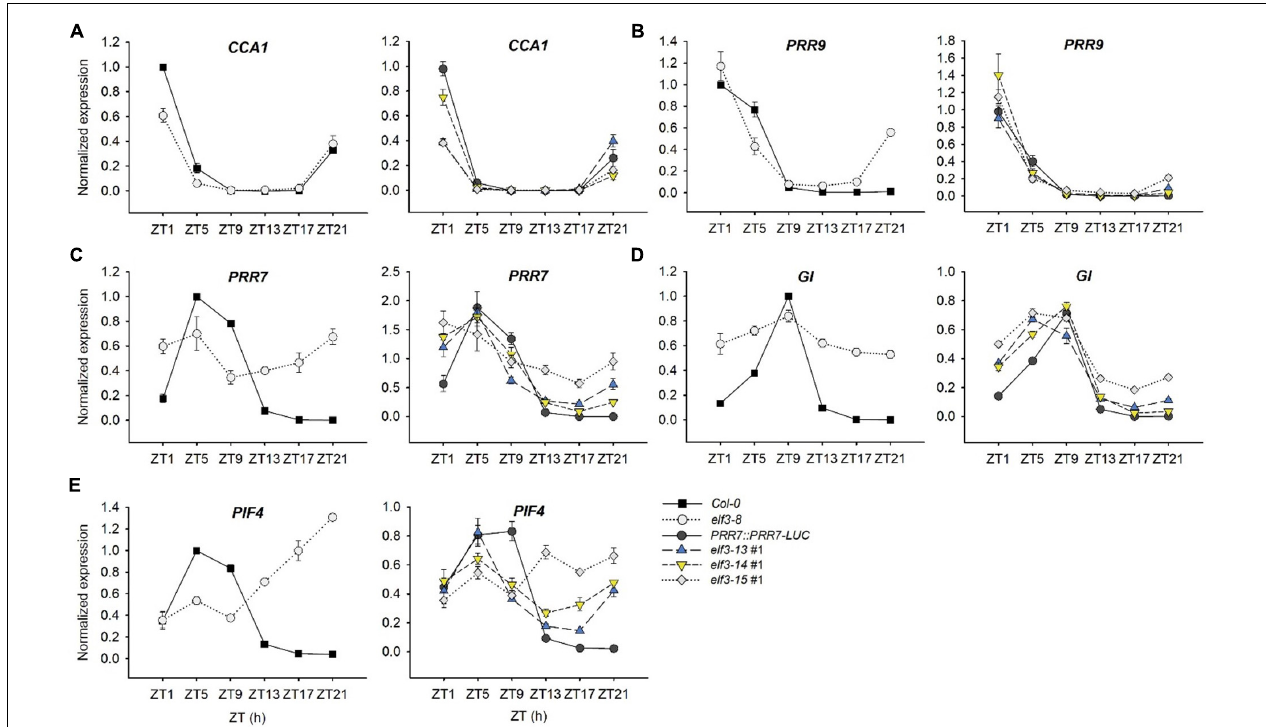
FIGURE 7 | Transcript abundance patterns of select clock genes in elf3 mutants. 11-day old seedlings were collected from ZT1 to ZT21 every 4 h under 12L:12D white-light cycles. Input RNA was normalized to a U-box gene (At5g15400) and expression levels of each transcript were standardized to the peak levels in Col-0 set to 1. (A) Transcript profile of CCA1 . (B) Transcript profile of PRR9 . (C) Transcript profile of PRR7 . (D) Transcript profile of GI . (E) Transcript profile of PIF4 . Error bars show SEM from three biological